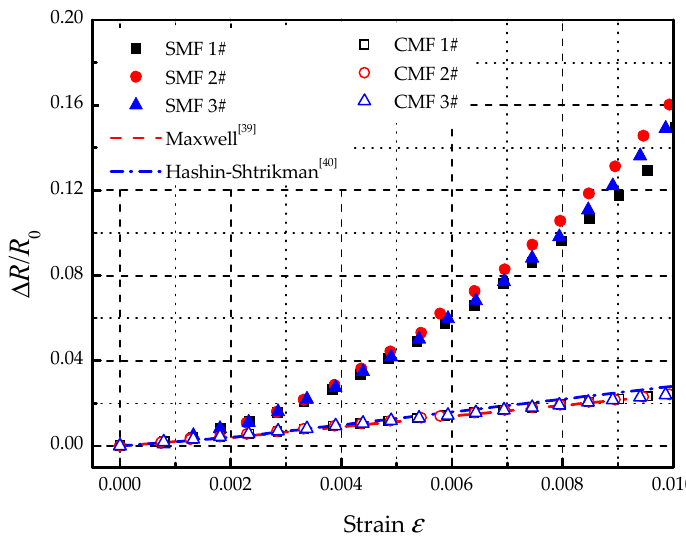
Figure 12. Specimen with conventional metal film (CMF) affixed on the surface.